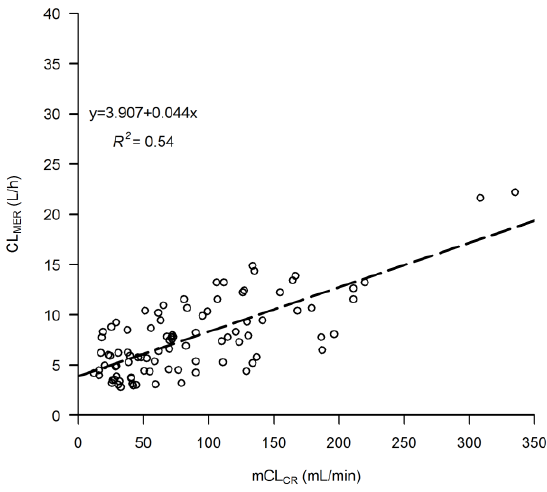
Figure 1. Linear regression between meropenem clearance (CL M ) vs. measured creatinine clearance (mCL CR ). The dashed line represents the line of regression.